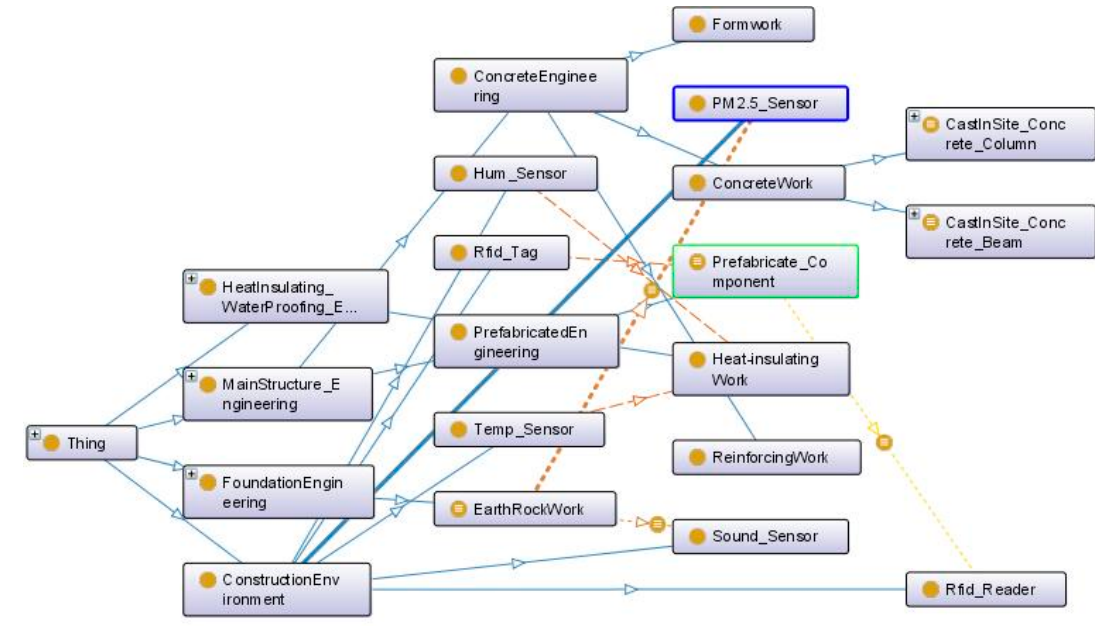
Figure 19. The diagram of classes and properties in construction condition ontology.